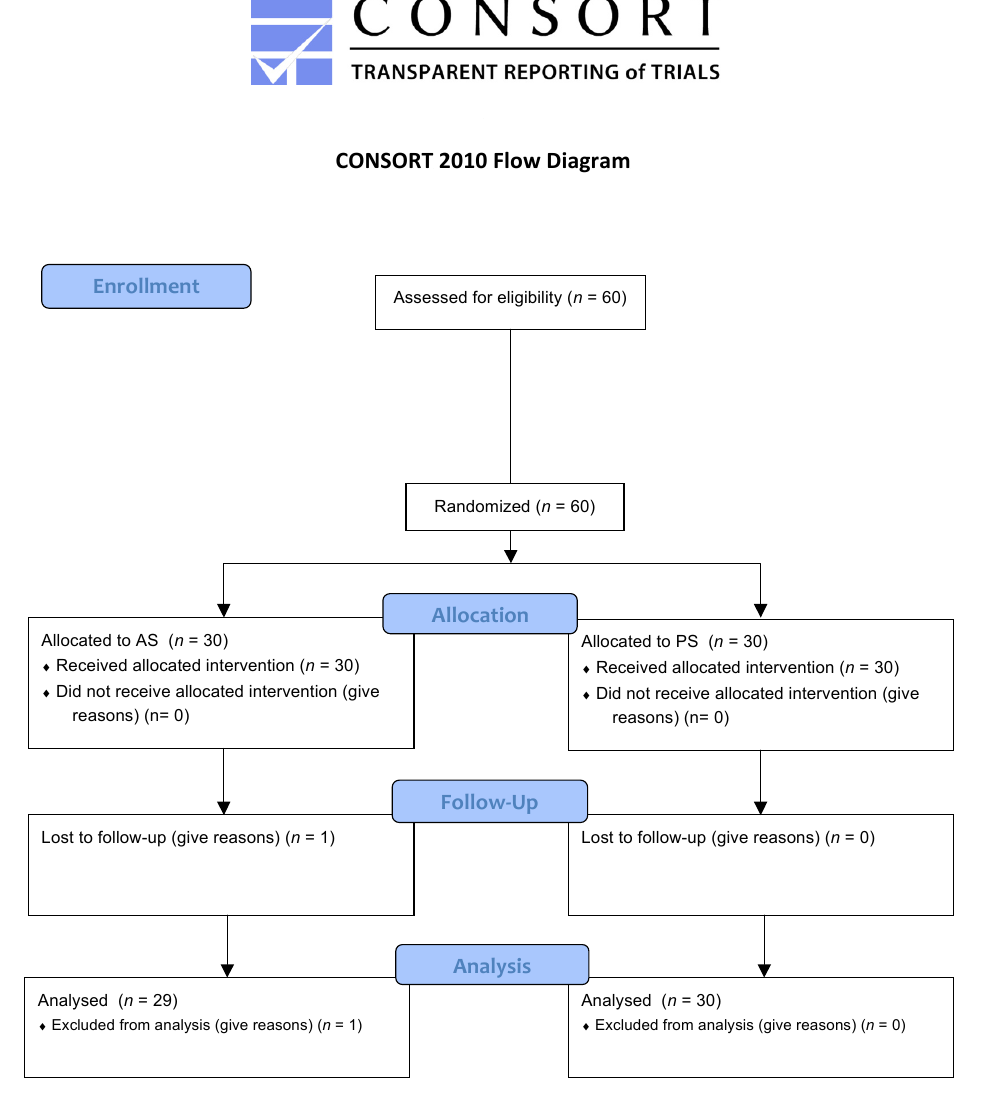
Figure 1. Consort 2010 flow diagram.